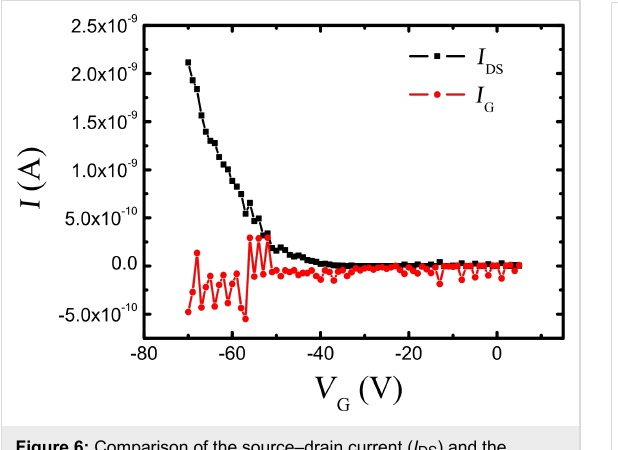
Figure 6: Comparison of the source–drain current ( I DS ) and the leakage gate current ( I G ) from the transfer characterization of the Al(Op) 3 -based TFT with a channel length of 100 μ m. The source–drain bias, V DS , for this measurement is − 70 V. I SD currents are far higher than I G in the high voltage regime, indicating that the mobility calcu- lated from the transfer curves is reliable and not impacted by the leakage current.